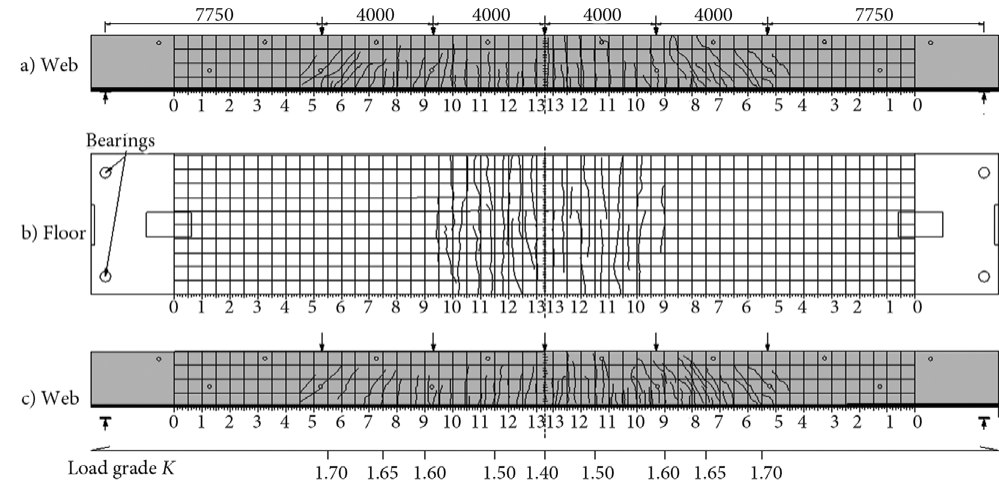
Fig. 7. Experimentally observed cracking patterns from the static load test for 32 m standard